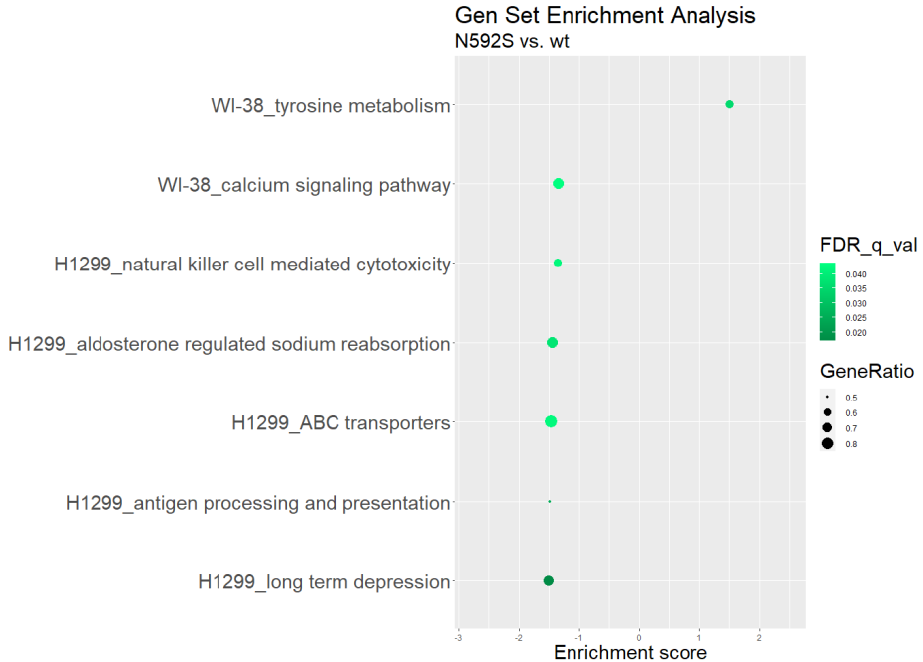
Figure 8. Gen set enrichment analysis showing the positive or negative effect of TLR5 N592S variant on gene set enrichment in H1299 and WI-38 cell line. Size of the dots represents ratio of DEGs in comparison to total number of genes in a given set.